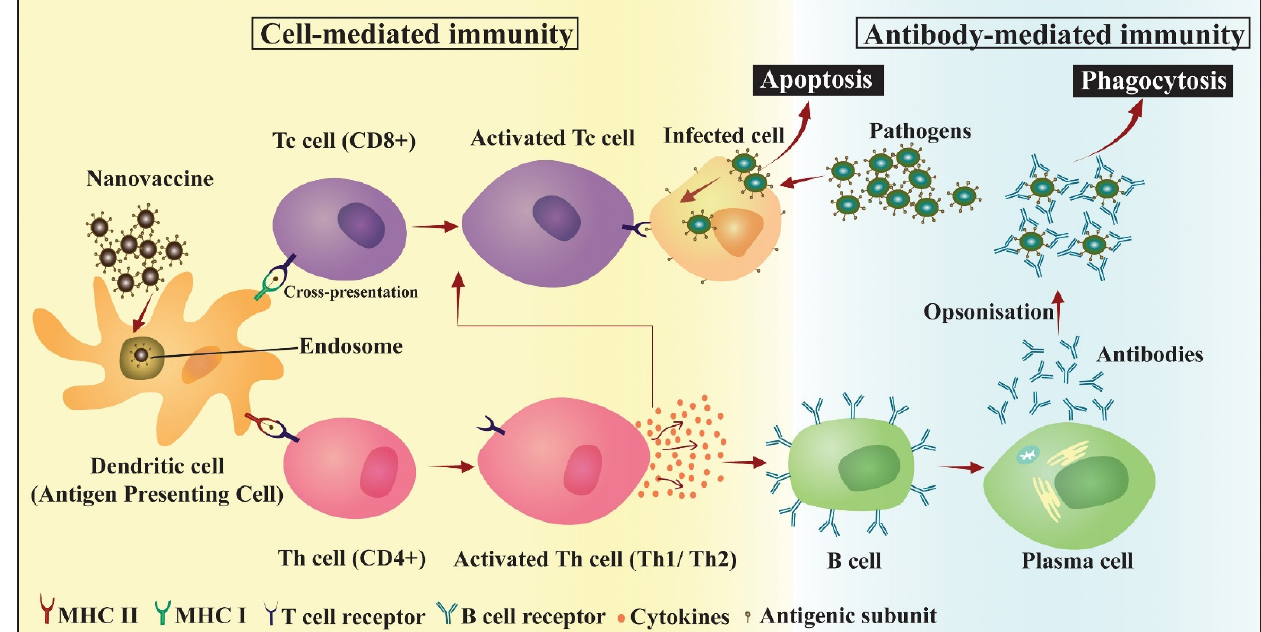
Figure 8. Activation of adaptive immunity by nanovaccines: uptake and presentation of antigenic subunit by APCs elicit cell-mediated and antibody-mediated immune response, leading to apoptosis of infected cells and phagocytosis of antibody–pathogen complex. Reprinted from an open-access source [18].